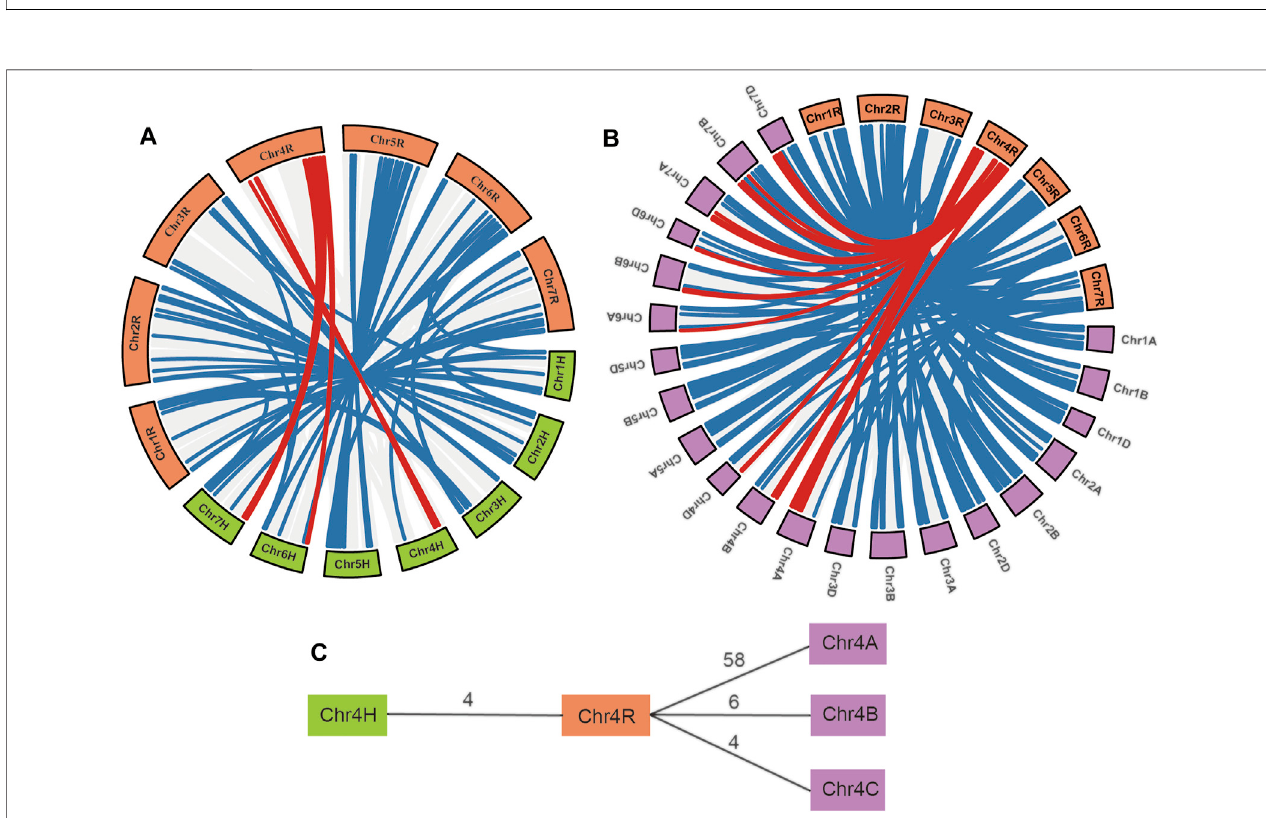
FIGURE 4 | Cross-species synteny of S. cereale NBS-LRR genes. (A) Cross-species synteny between S. cereale and H. vulgare . (B) . Cross-species synteny between S. cereale and T. aestivum . Gene pairs involving NBS-LRR genes on chromosome 4 of S. cereale were labeled with a red line. (C) Comparative analysis of synteny NBS-LRR pairs between S. cereale and H. vulgare with synteny NBS-LRR pairs between S. cereale and T. aestivum .